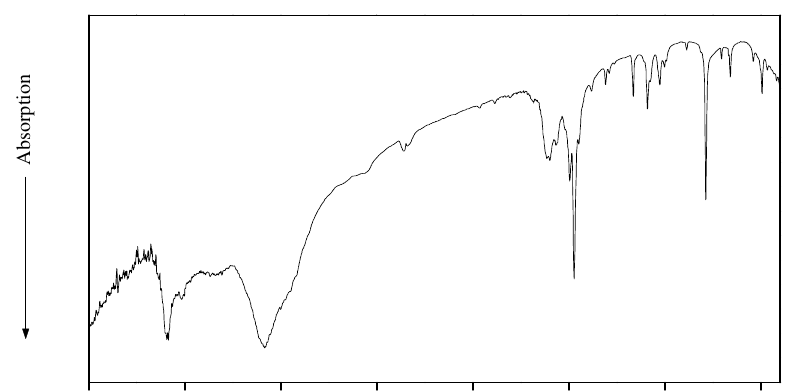
Figure 4 . IR spectrum of [2,6-(CH